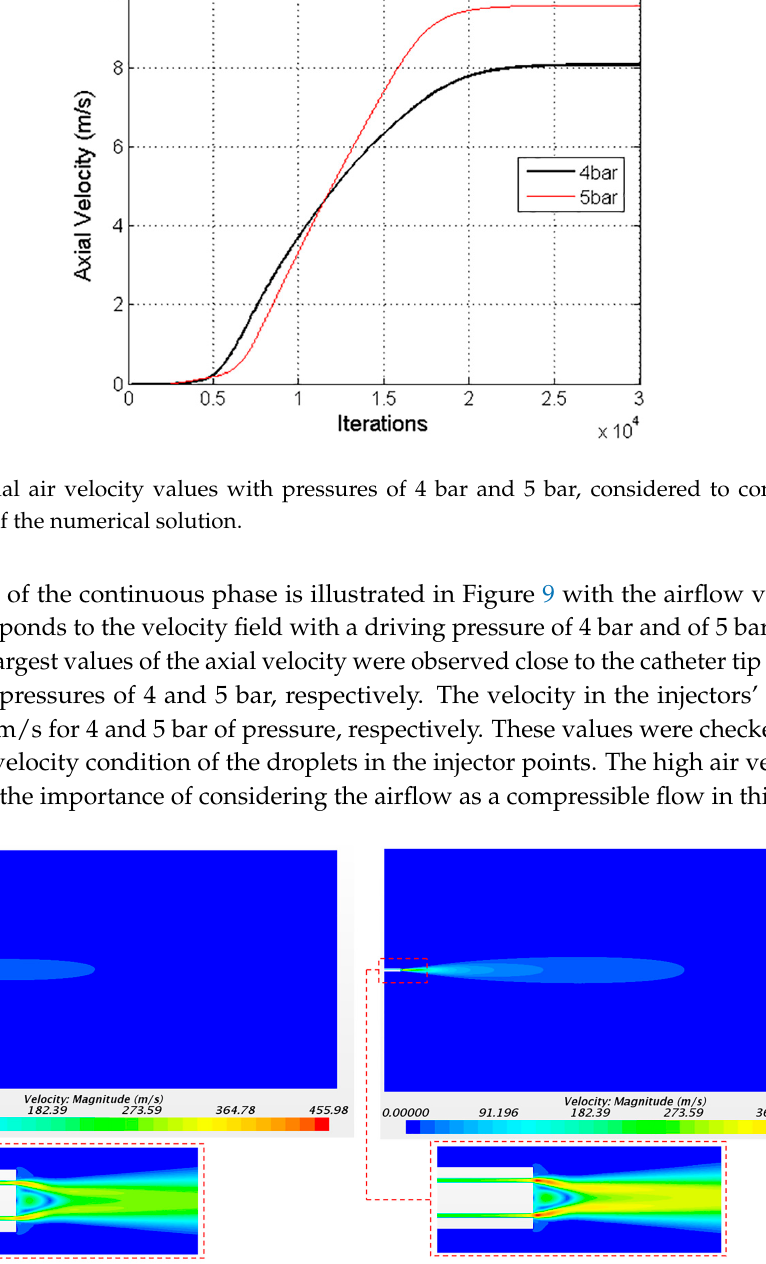
Figure 10. Particle size distribution of the FC75 discrete particles with a driving pressure of 4 bar. The axial velocity results with a pressure of 4 bar were monitored at several distances from the catheter tip and validated with the experimental results obtained by Goikoetxea et al. [37]. The turbulence model along with the mesh refinement generated close to the catheter tip led to an accurate prediction of the airflow velocity values, as shown in Figure 11. The results of the cumulative mass distribution as a function of the droplet size ( Y dg ) are presented in Figures 12 and 13 for PFD and FC75 compounds, respectively, and were compared with the experimental data obtained by means of the APS. Some differences were found between the numerical and the experimental results. The collision and coalescence of the particles may be the cause of those deviations. In the numerical model, which considered the breakup of particles with the TAB breakup model but not the coalescence, a higher cumulative mass fraction was obtained for particles above 3 μ m for the PFD compound at both pressures and for each distance. For the FC75 compound, with a pressure of 4 bar, the cumulative mass fraction was higher for particles below 5 μ m and considerable lower for particles above 10 μ m, whereas with a driving pressure of 5 bar there was a different pattern in the experimental results, and the cumulative mass fraction for particles above 10 μ m was considerable higher.